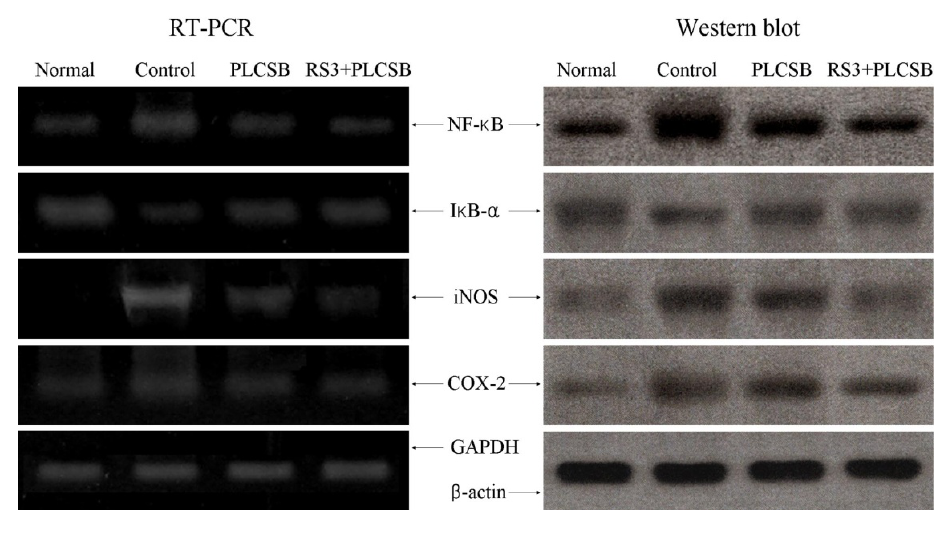
Figure 5. Effects of PLCSB and RS3 + PLCSB on mRNA and protein expression of NF- κ B , I κ B- α , iNOS and COX-2 in AOM and DSS-induced colon cancer mice.